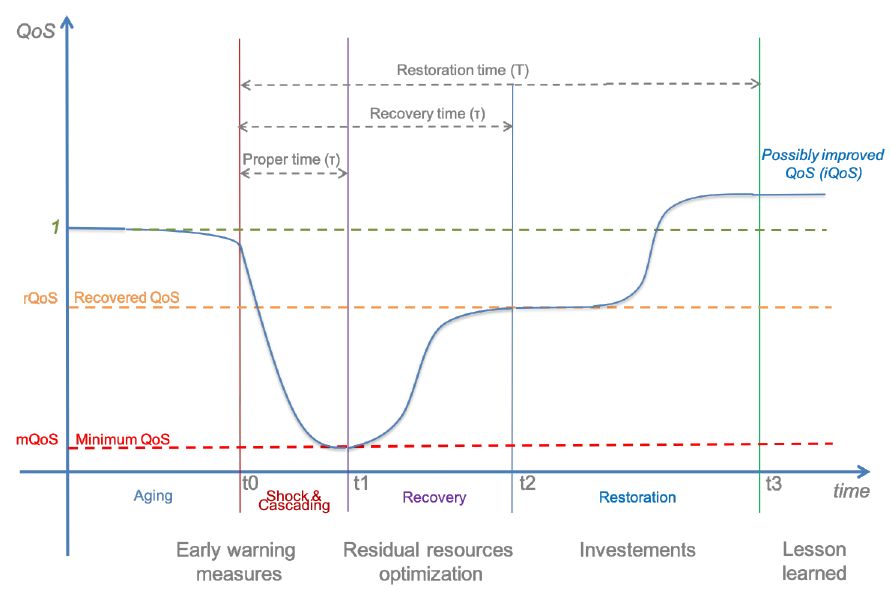
Figure 2. The system QoS during a contingency. t 0 : start time of shock and cascading, t 1 : degradation time, t 2 : recovery time, t 3 : restoration